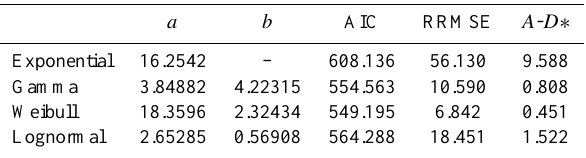
Table 3. Marginal distribution parameters and goodness of fit re- sults for duration ( D ).